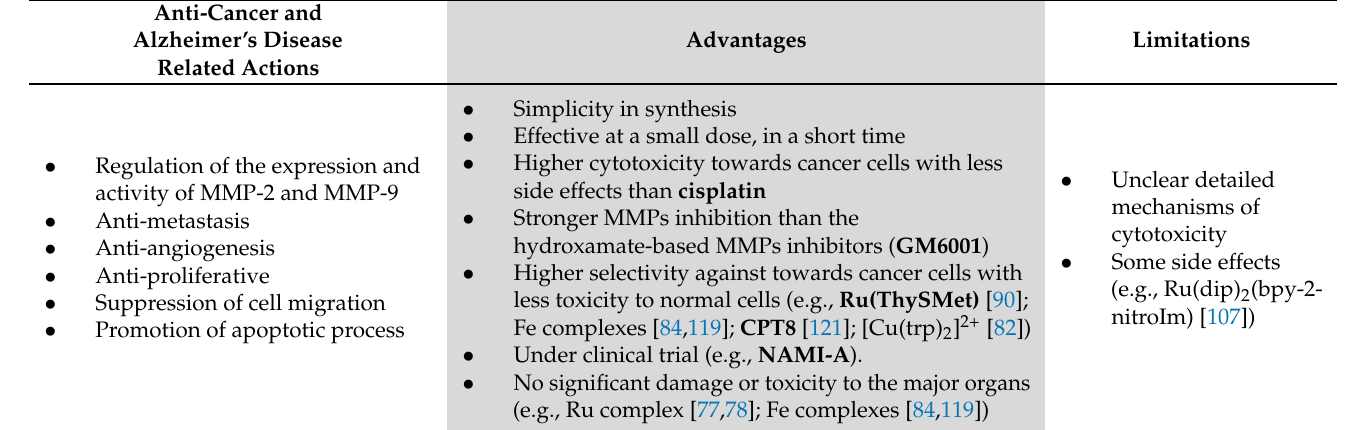
Table 2. A summary of general advantages and limitations of metal complexes mentioned